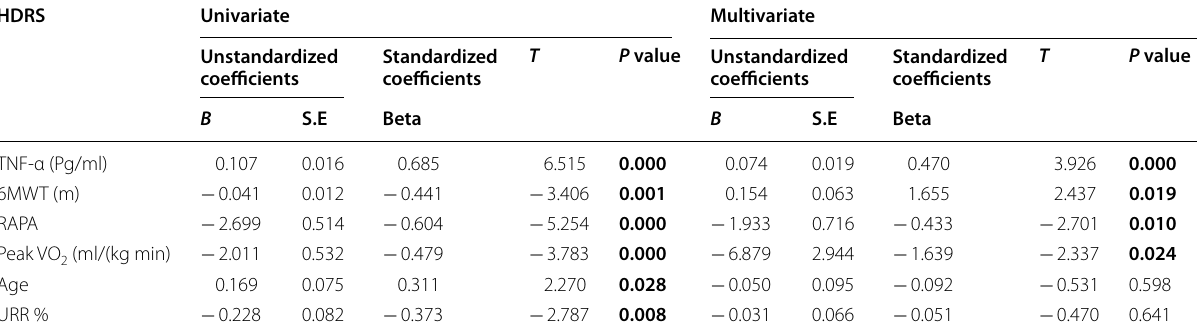
Table 5 Univariate and multivariate linear regression analysis for factors affecting HDRS after IDE